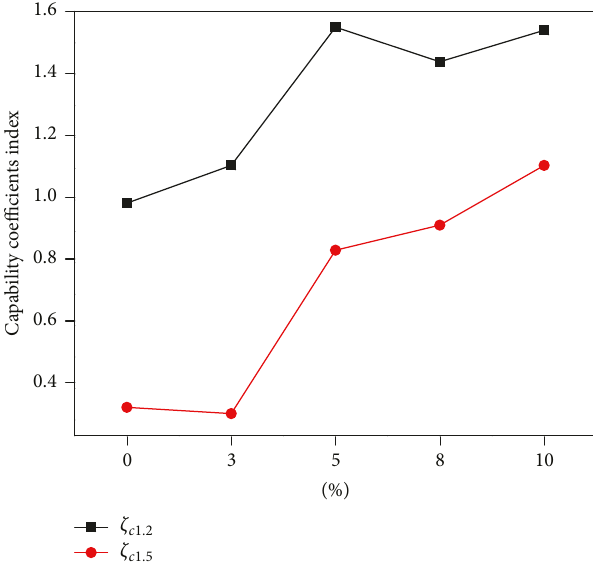
Figure 19: Capability coefficients index of CaCO 3 whisker rein- forced cement